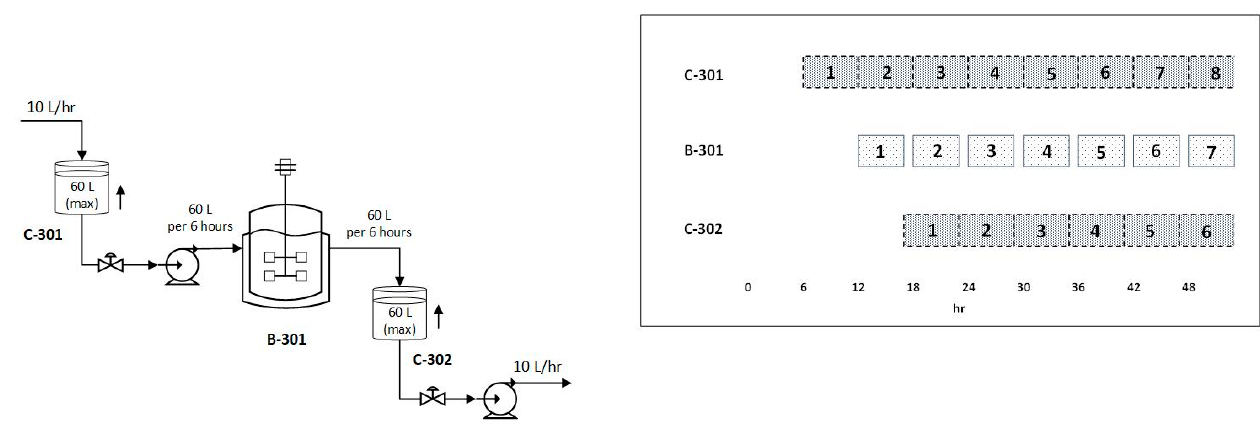
Figure 4. Flow rate and correlated operational time schedule for the alkaline cell lysis reactor B-301 and the auxiliary accumulation balancing vessels C-301, C-302.